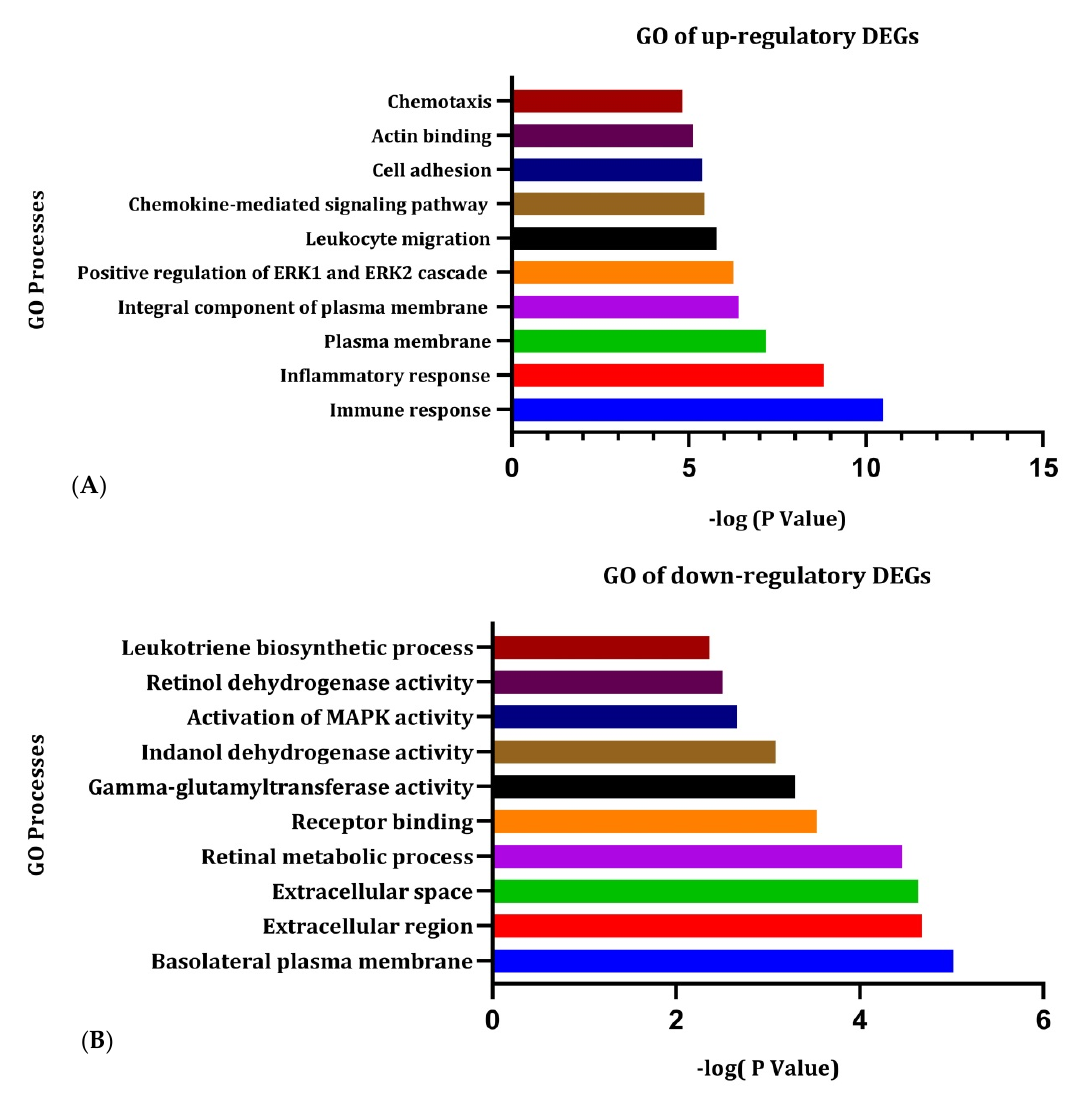
Figure 3. Functional analyses of the differentially expressed genes (DEGs) in cervical cancer. In figure ( A ), GO of up-regulatory DEGs and in ( B ). GO of down-regulatory DEGs. Each of the GO processes was plotted based on the -log (p) value.